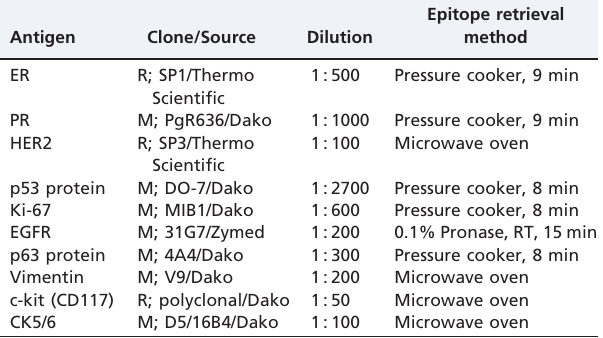
Table 1 - Reagents and methods used for immunohistochemical analysis.